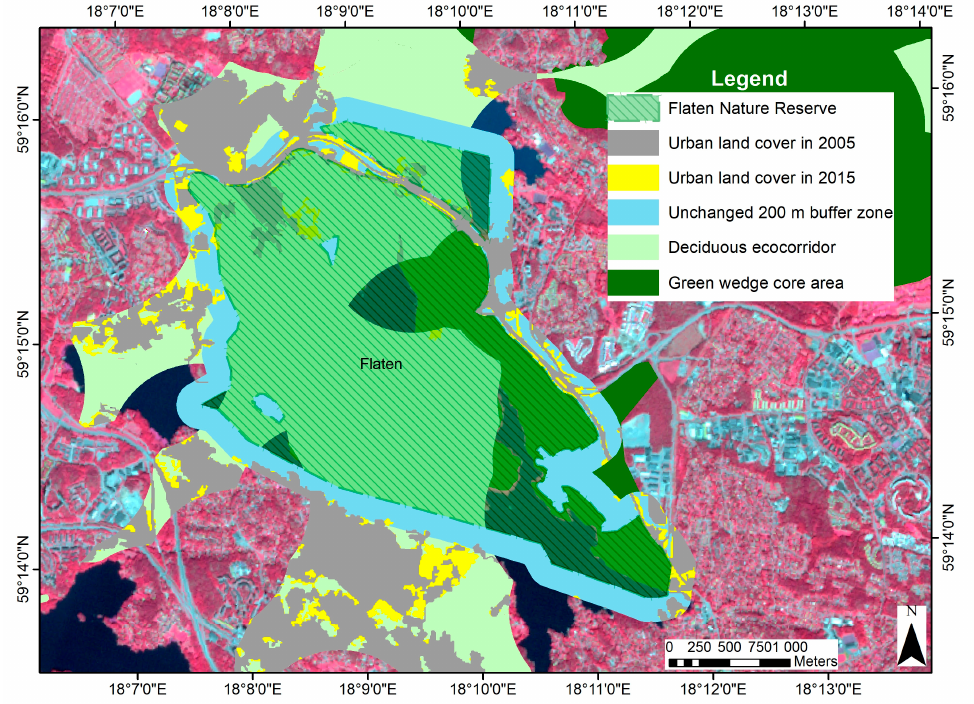
Figure 13. Change in urban land cover near Skarpnäck, Trångsund and Älta in and around three different types of Stockholm’s green infrastructure: Flaten nature reserve buffer zone, a deciduous forest ecocorridor and green wedge core area.